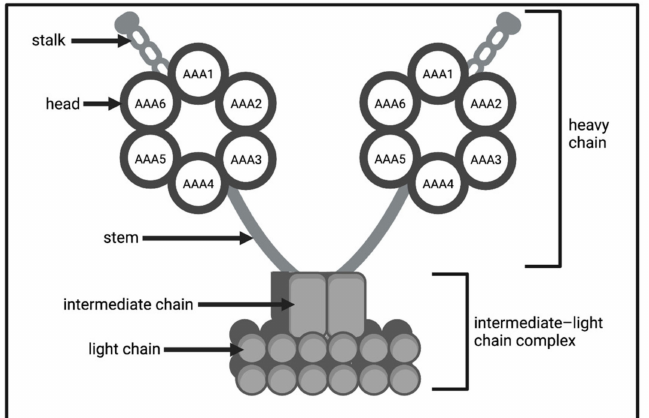
Figure 2. Outer dynein arm structure. Outer dynein arms consist of an an intermediate–light chain complex, along with heavy chain structures each composed of a head, a stalk and a stem [31]. The stem binds the intermediate–light chain complex to the head [38]. The head is an ATPase associated (AAA) ring which consists of six AAA domains (AAA1-6). AAA1 is the primary ATPase site responsible for the hydrolysis of ATP [38]. The function of the remaining AAA domains (AAA2-6) is largely unknown however it is thought that they are important for structure and regulation of dynein movement [39]. The stalk is connected to the head and has a microtubule binding domain at its tip